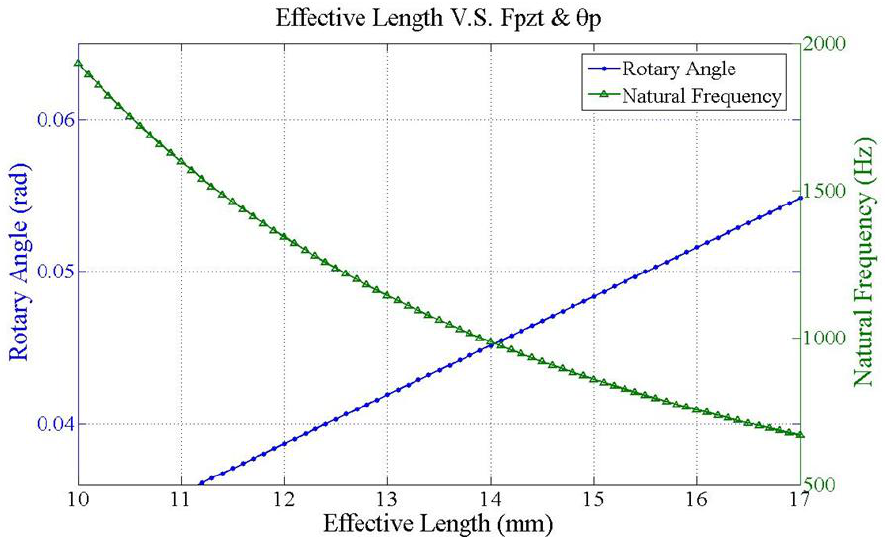
Figure 8. Effective length versus optimal balance between rotary angle (rad) and natural frequency